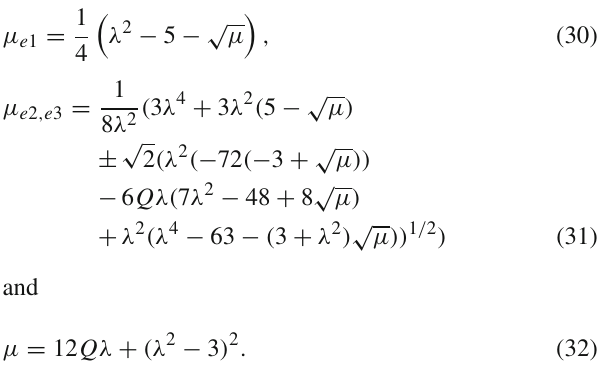
See the main text Saddle